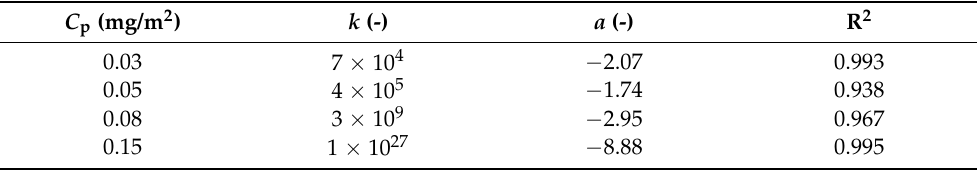
Table 2. The parameters of the power-law approximation are calculated using Equation (3), where t G . γ to the shear rate. The values of k and a are the constants of the corresponds to the gelation time and power–law relationship, and the values of a correspond to the slope of the graph. The values of R 2 are the coefficient of determination for the least-squares